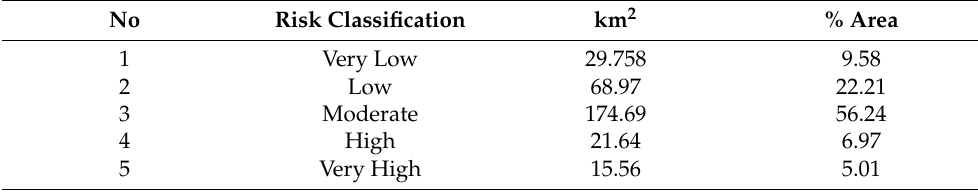
Table 6. Classification of flood risk and area of land cover.